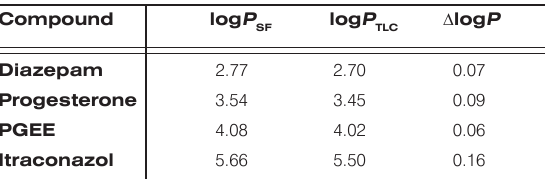
and l og P values of the compounds of the SF TLC validation set.